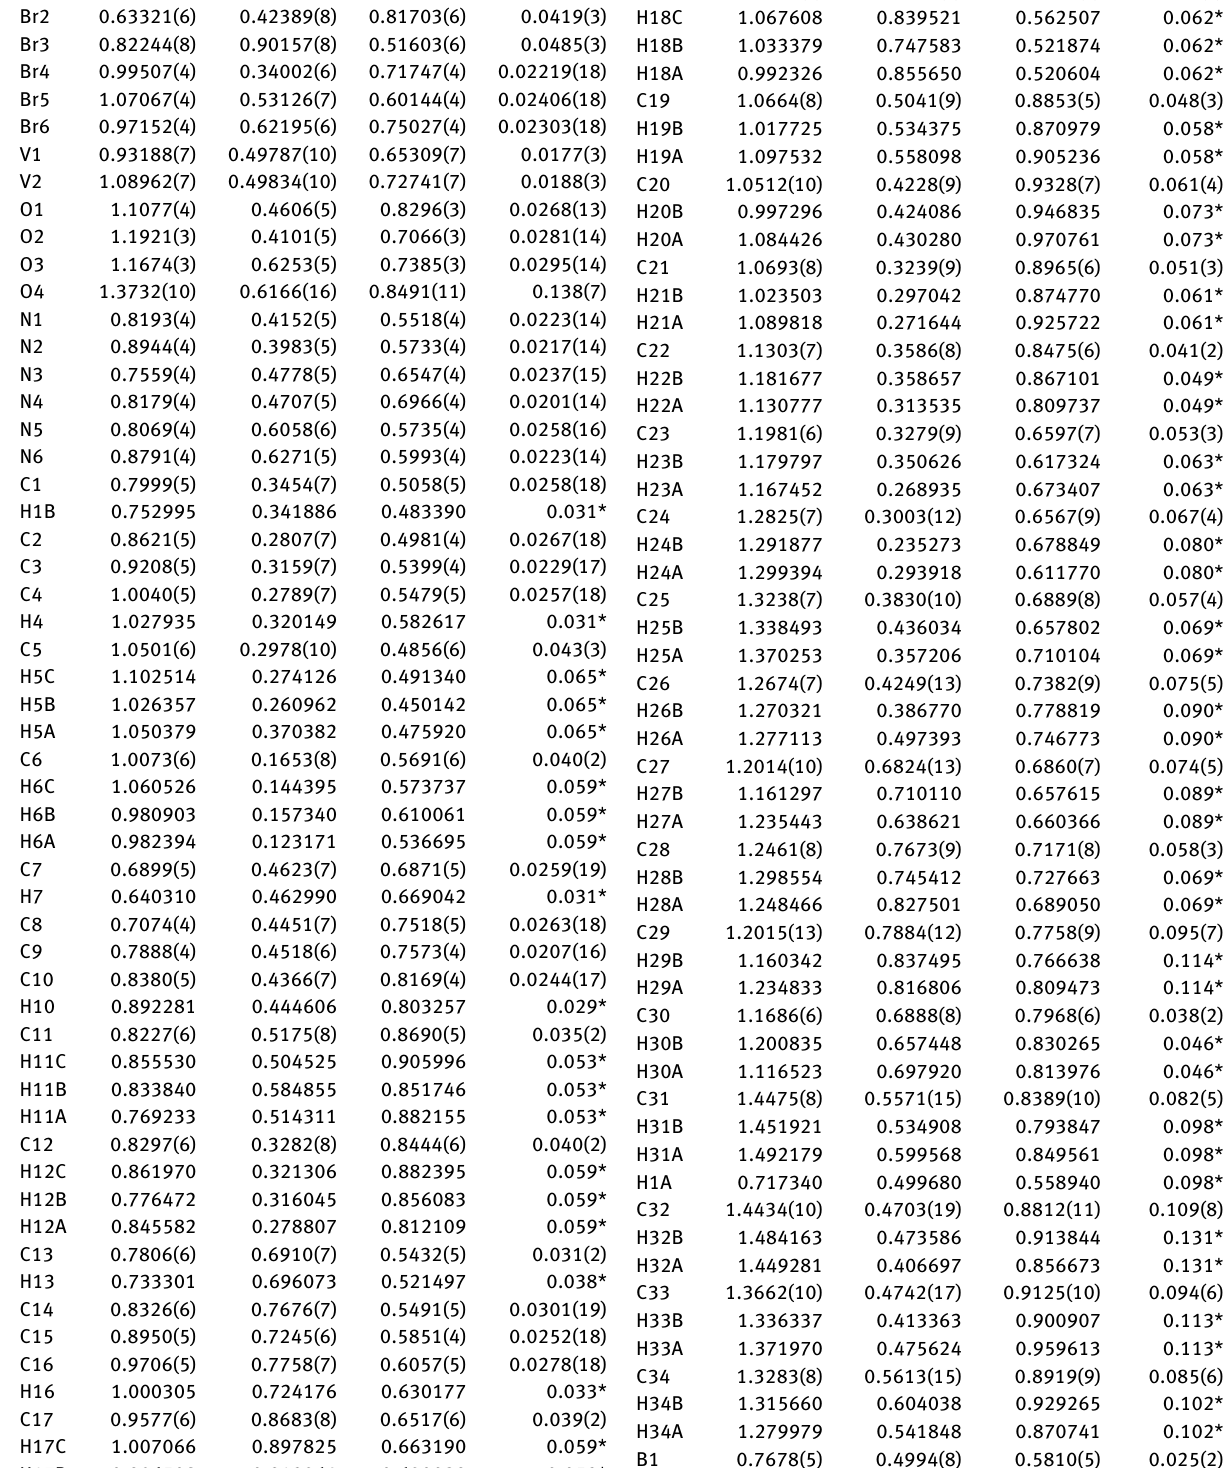
Table 2: Fractional atomic coordinates and isotropic or equivalent isotropic displacement parameters (Å 2